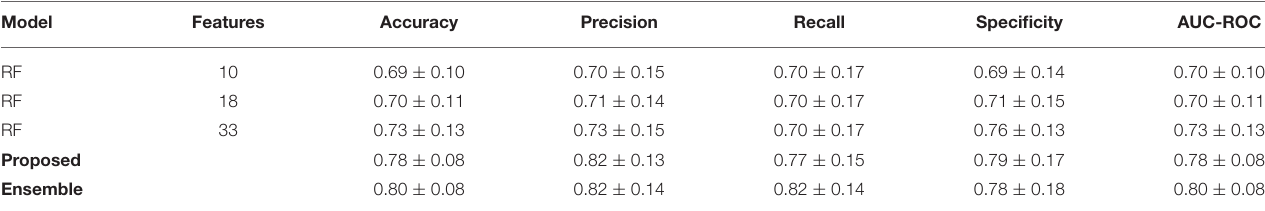
TABLE 3 | Results of the classification performed by the RF, the proposed deep learning model, and the ensemble learning method.